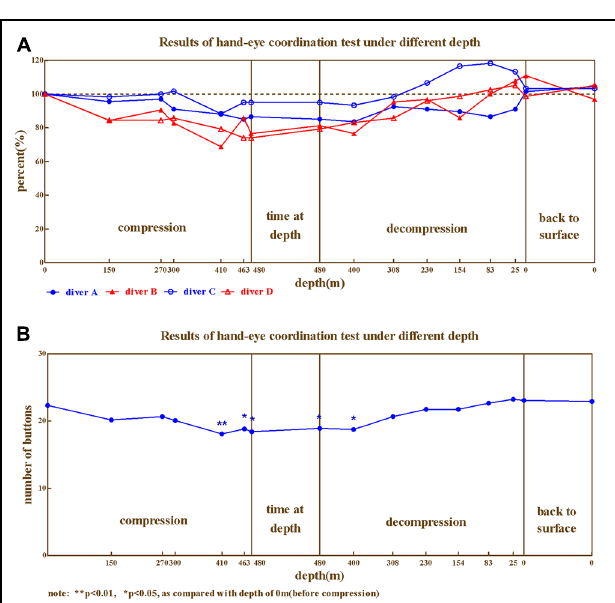
FIGURE 6 | The results from hand–eye coordination. (A) Four divers, (B) Average.